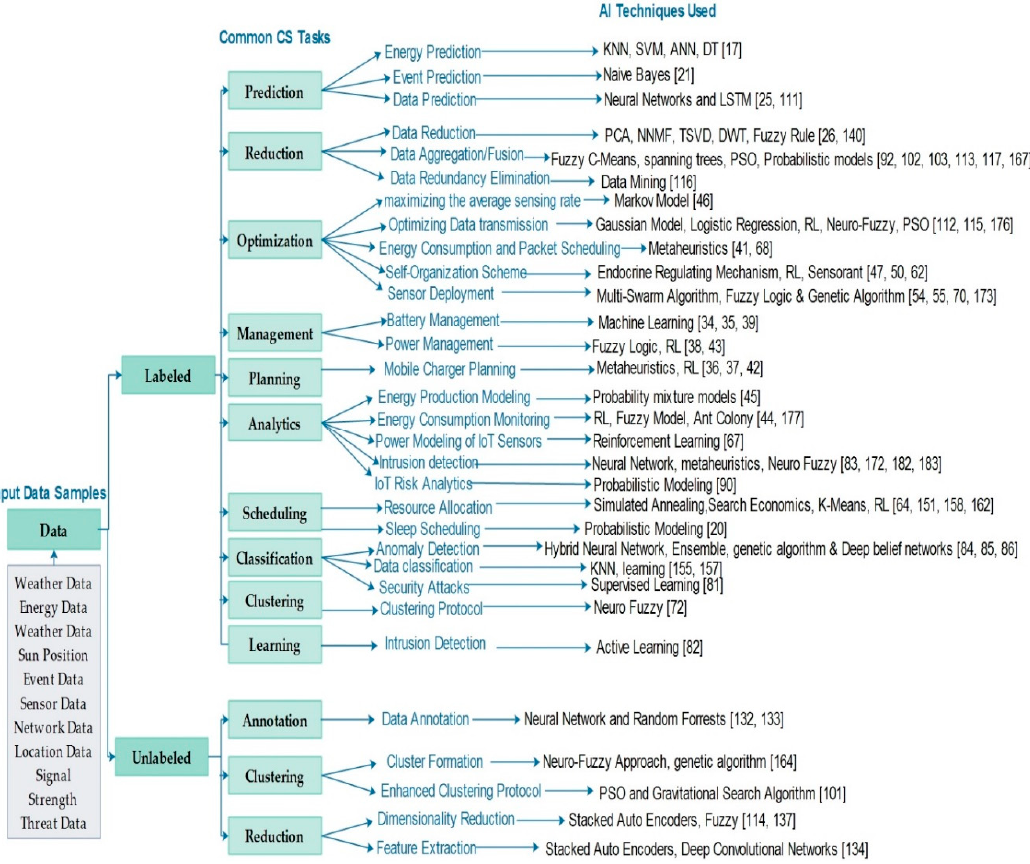
Figure 11. Common CS tasks and the choice of AI Techniques used in the literature .